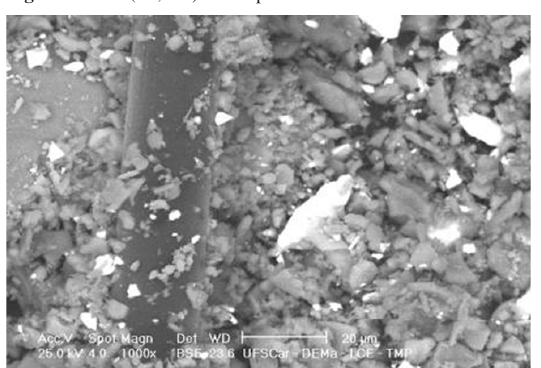
Figure 5. BSE (×1,000) of TR